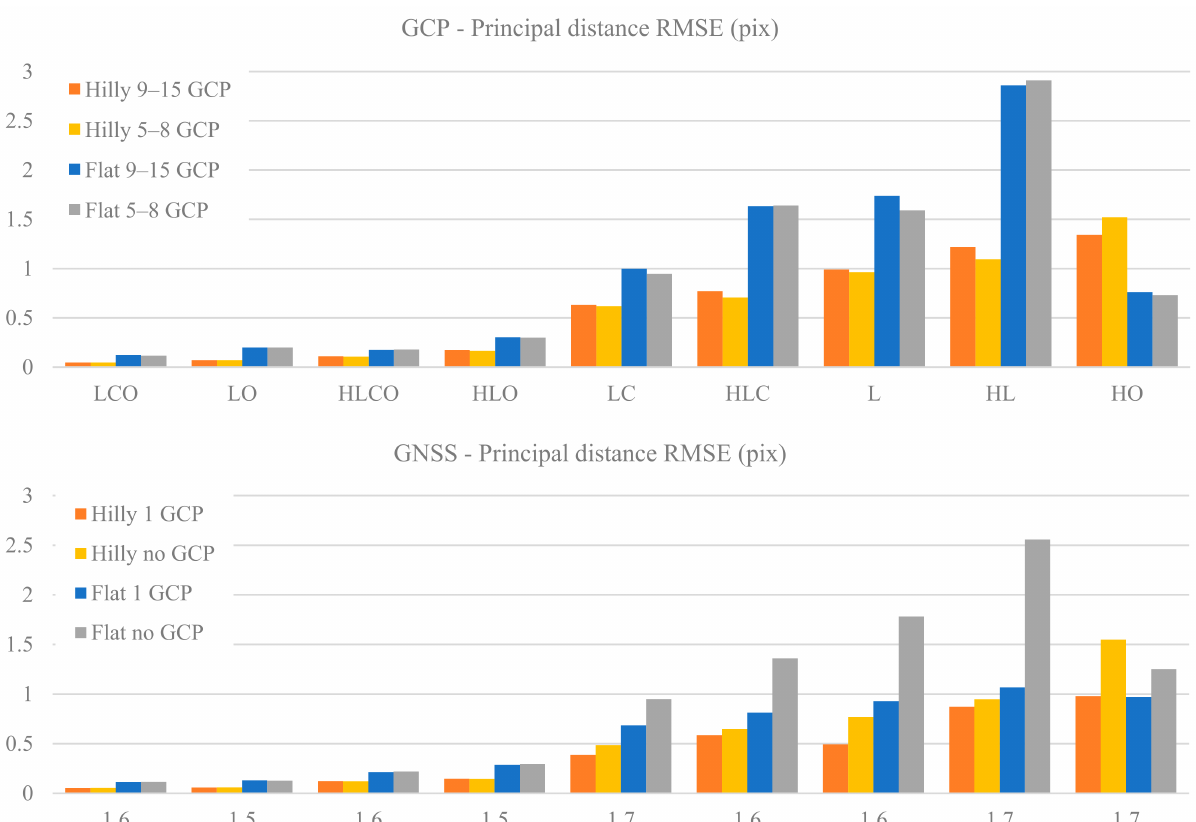
Figure 3. RMSE of the principal distance as a function of block type, terrain type and control tightness: ( top ): GCP case; ( bottom ): GNSS